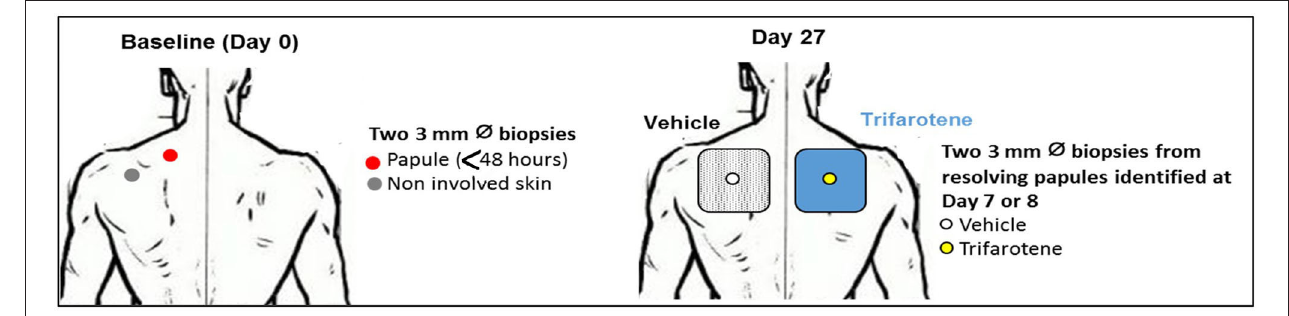
FIGURE 1 | Location of biopsies at Day 0 and Day